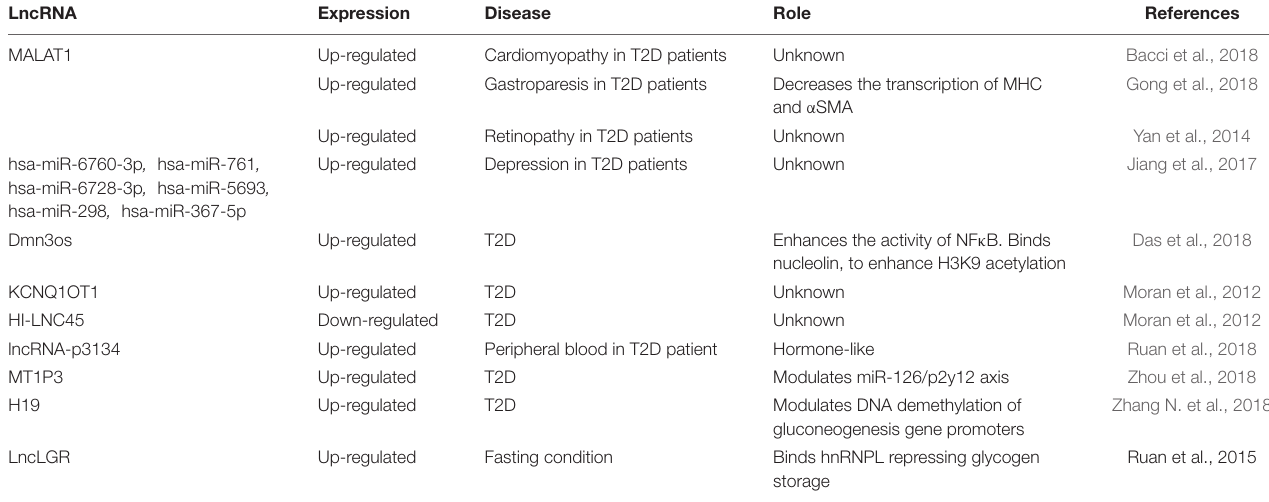
TABLE 6 | LncRNAs in dysmetabolic